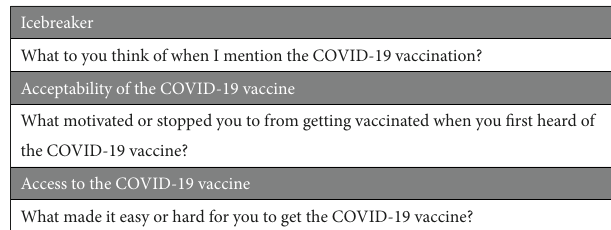
TABLE 1 Selection of interview guide